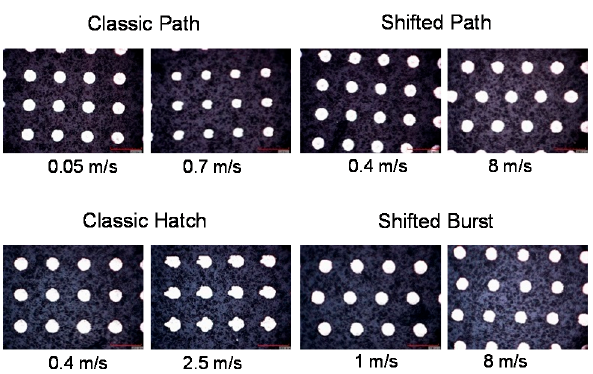
Figure 6. Microscope pictures of the surface dimple shapes for different texturing methods (scanning strategies) and laser beam speeds.